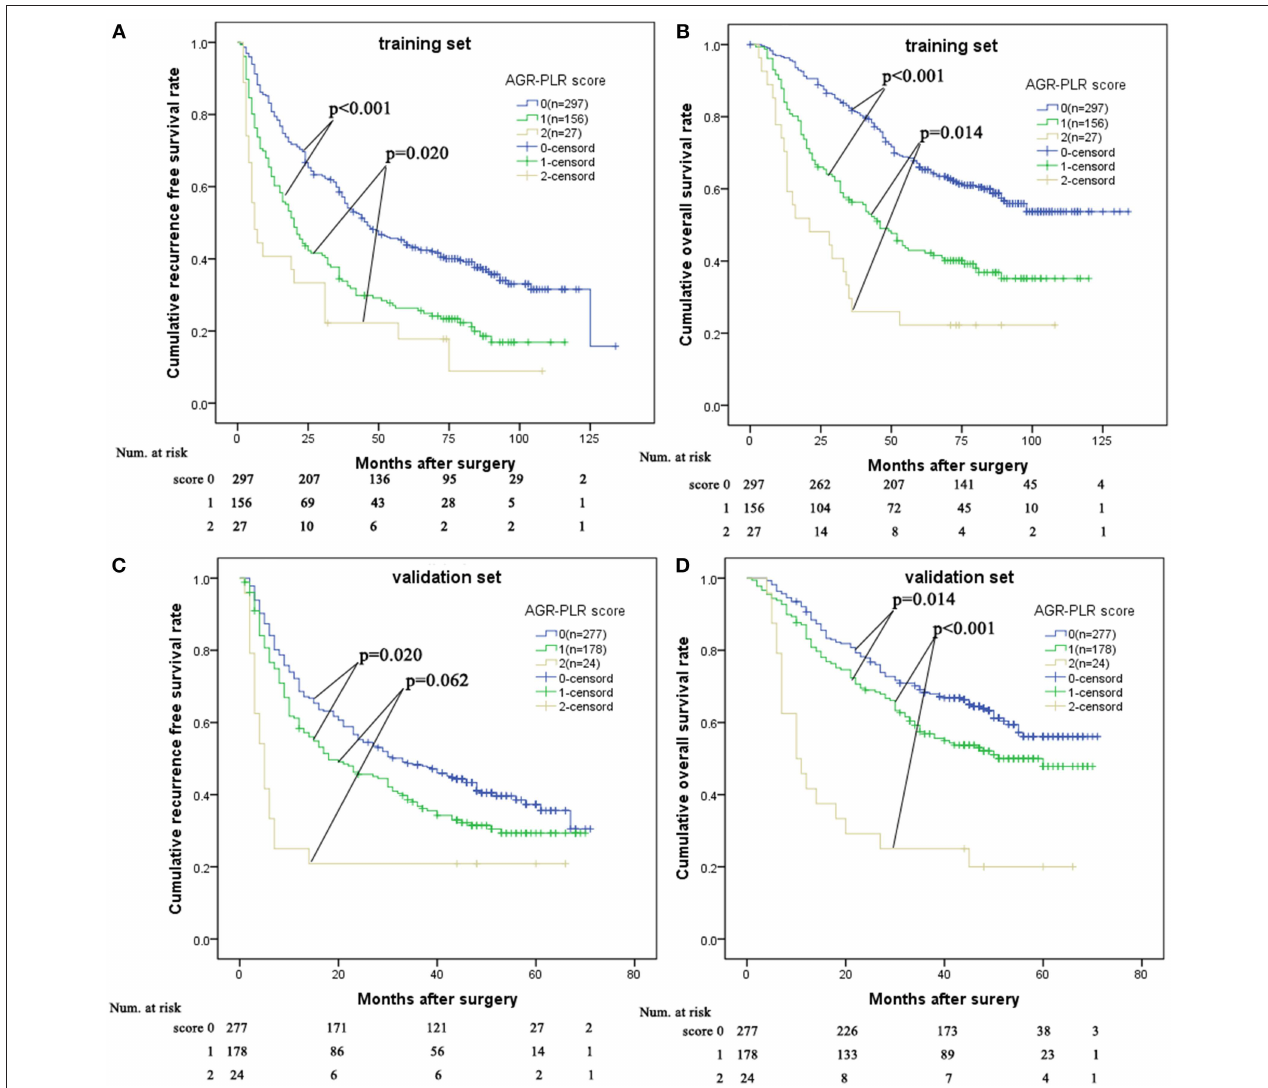
FIGURE 4 | Comparison of prognosis among AGR-PLR score 0, 1, and 2 in the training set and validation set. AGR-PLR score 1 had better RFS and OS than AGR-PLR score 2, worse RFS and OS than AGR-PLR score 0 in the training set (A,B) and validation set (C,D) .